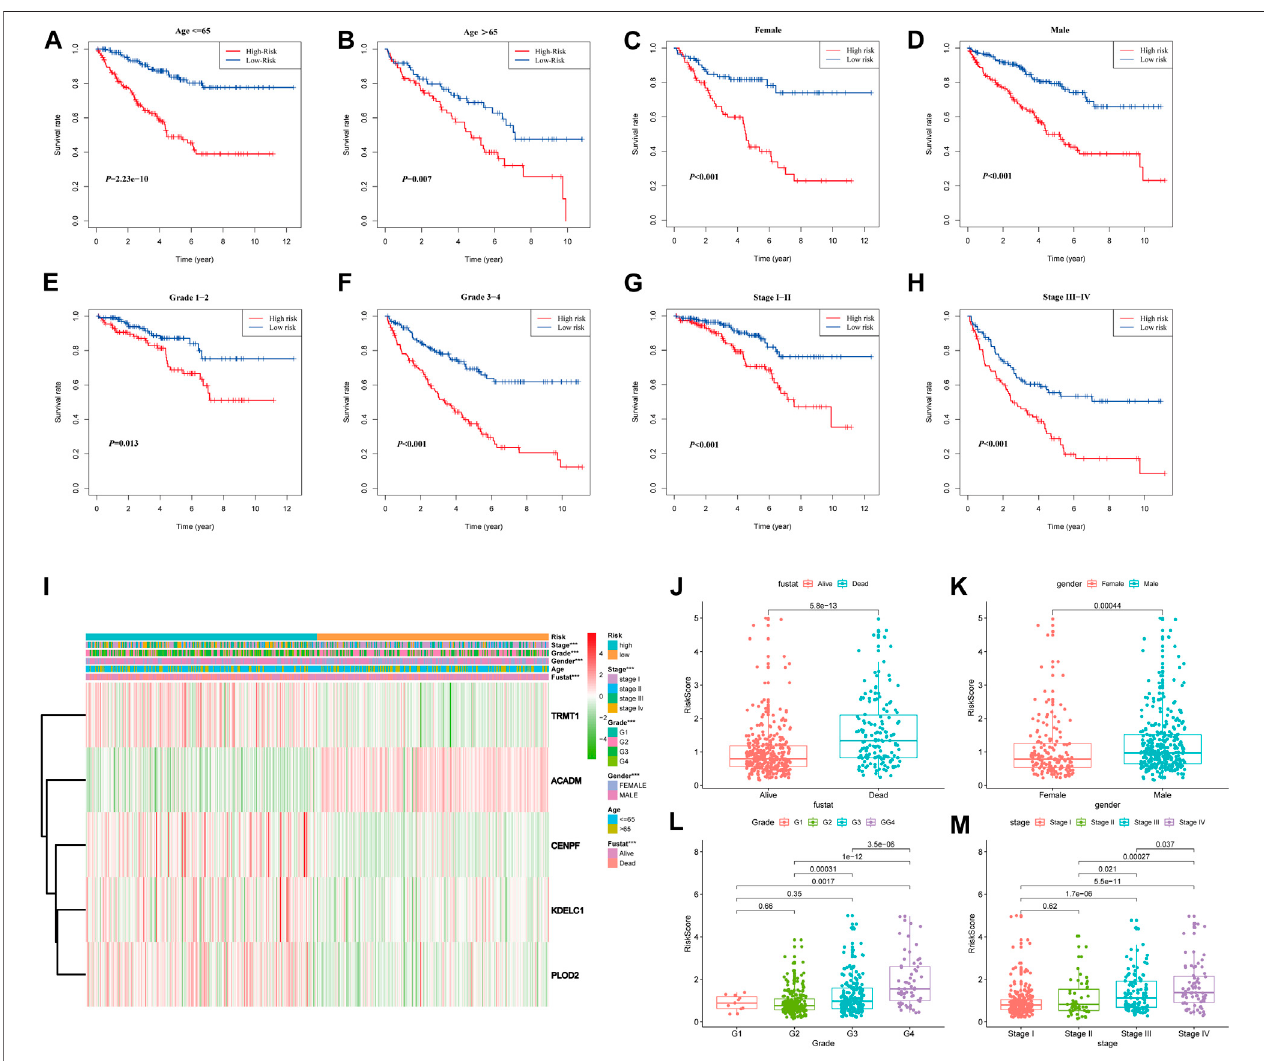
FIGURE 7 | Strati fi ed analyses based on the prognostic signature in the entire TCGA-KIRC cohort; (A – H) Kaplan – Meier survival analyses in different clinical characteristic subgroups; (I) Gene expression and clinicopathologic feature distribution of low- and high-risk groups; (J – M) Risk scores of patients strati fi ed by survival status, gender, grade, and